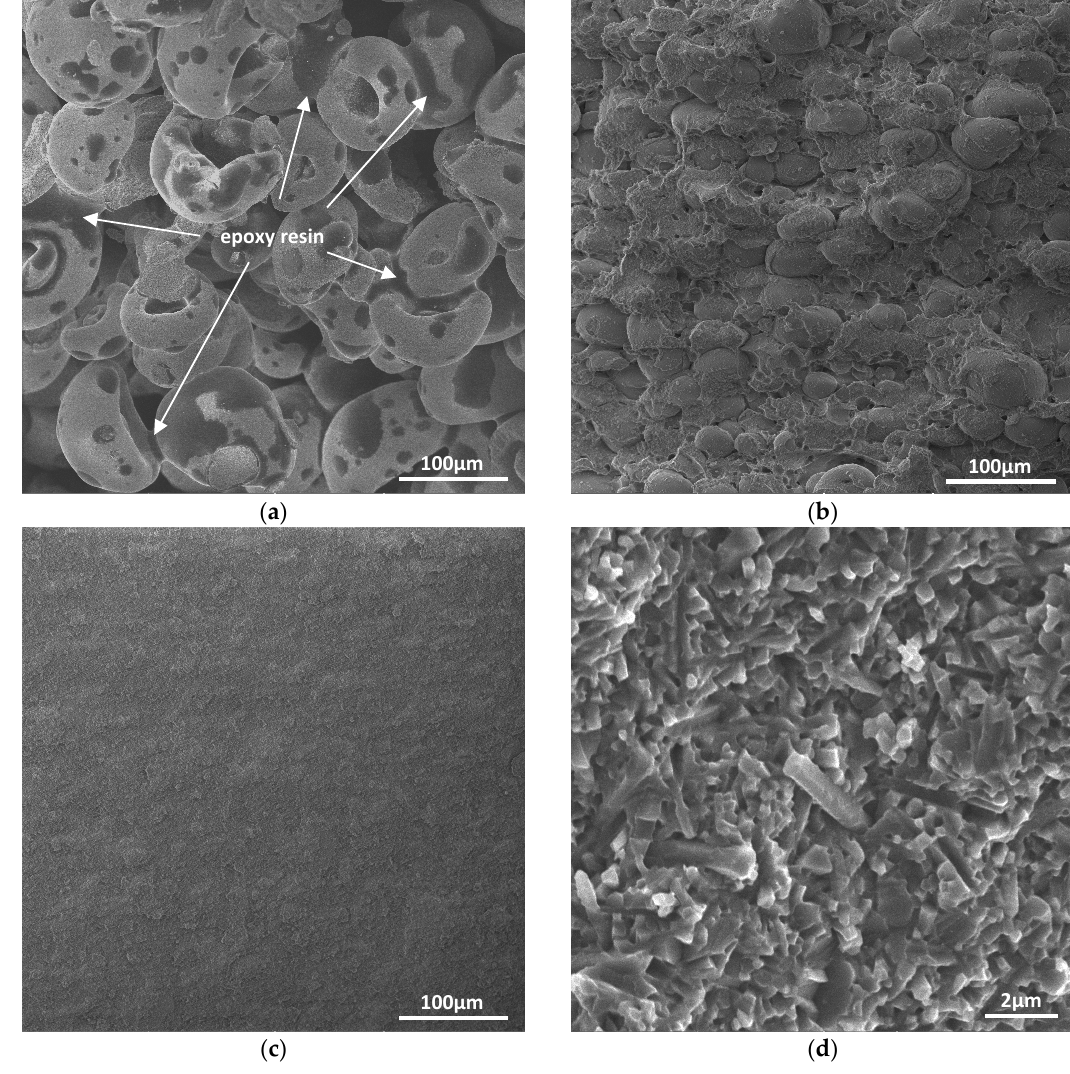
Figure 4. SEM micrographs of the hemispherical housings in different processes. ( a ) The printed greenbody before cold isostatic pressing CIP, ( b ) the first CIPed and debinded greenbody, ( c ) the second CIPed greenbody, and ( d ) the sintered Si 3 N 4 body.